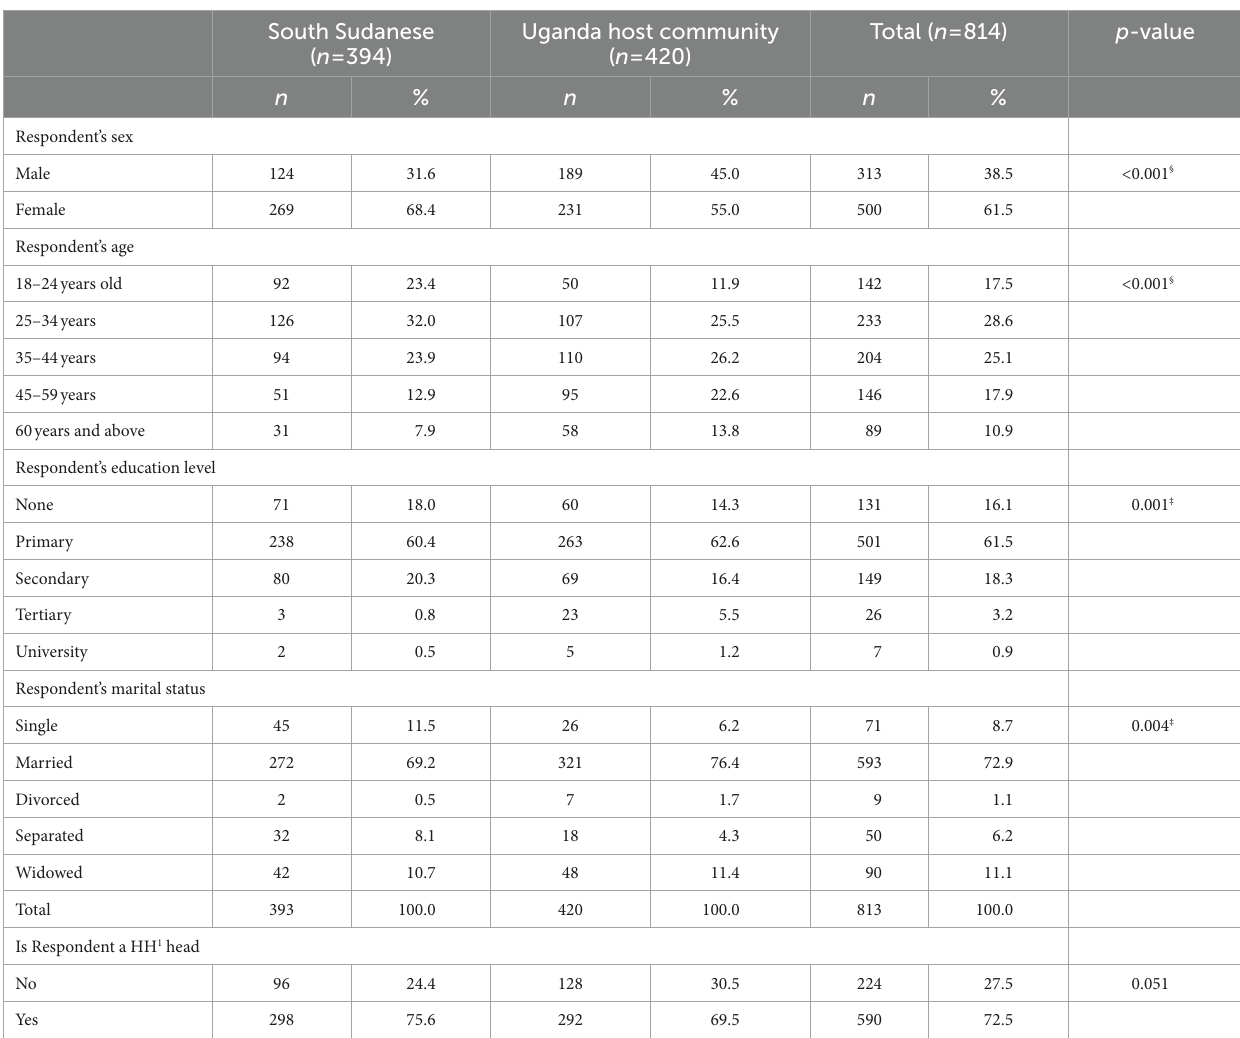
TABLE 1 Demographic characteristics of the